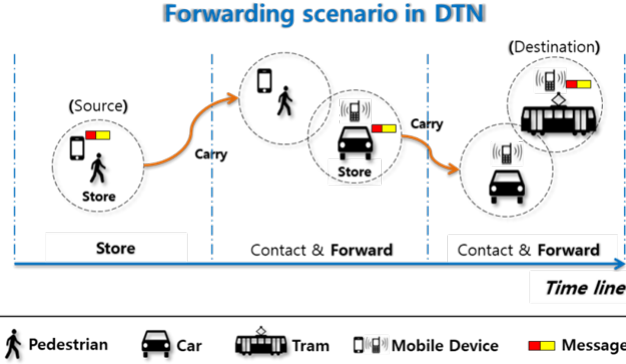
Figure 1. Store-carry-forward mechanism in delay tolerant network (DTN).